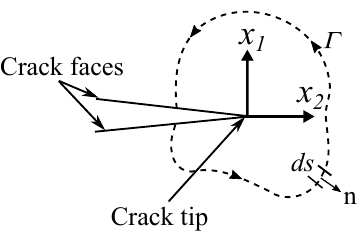
Figure 3. Definition of the contour path around the crack tip to compute the J